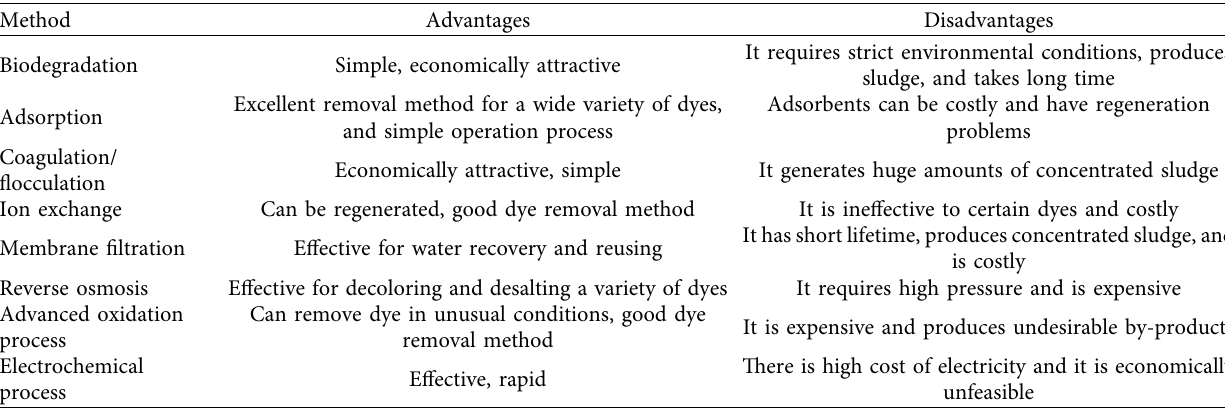
Figure 1: Types of dyes used in different industries [17]. Table 2: Different dyes removal methods along with their advantages and disadvantages [8, 9,